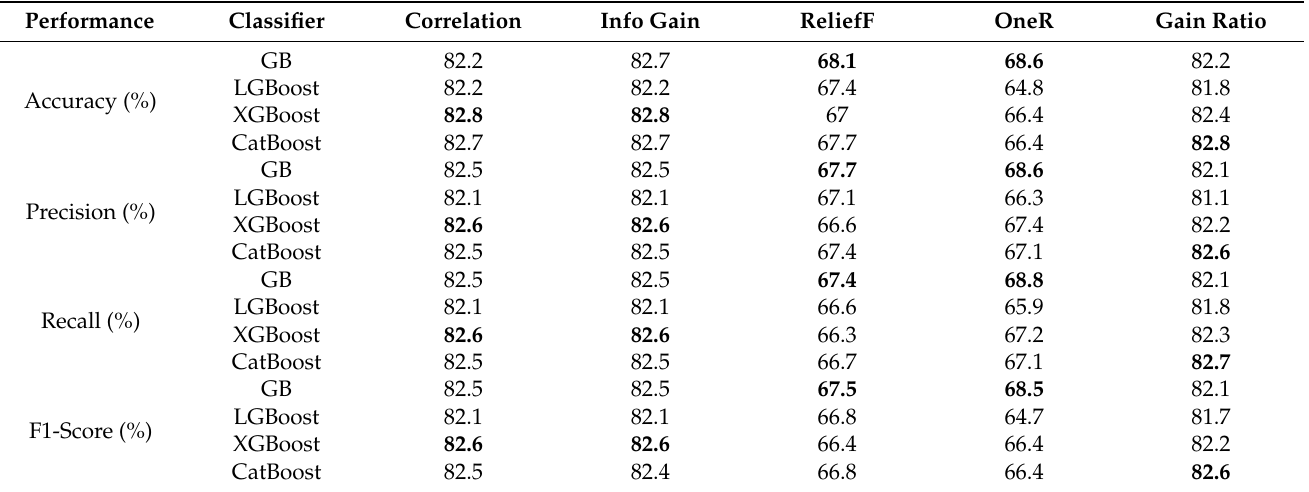
Table 5. Random undersampling to each feature selection technique.